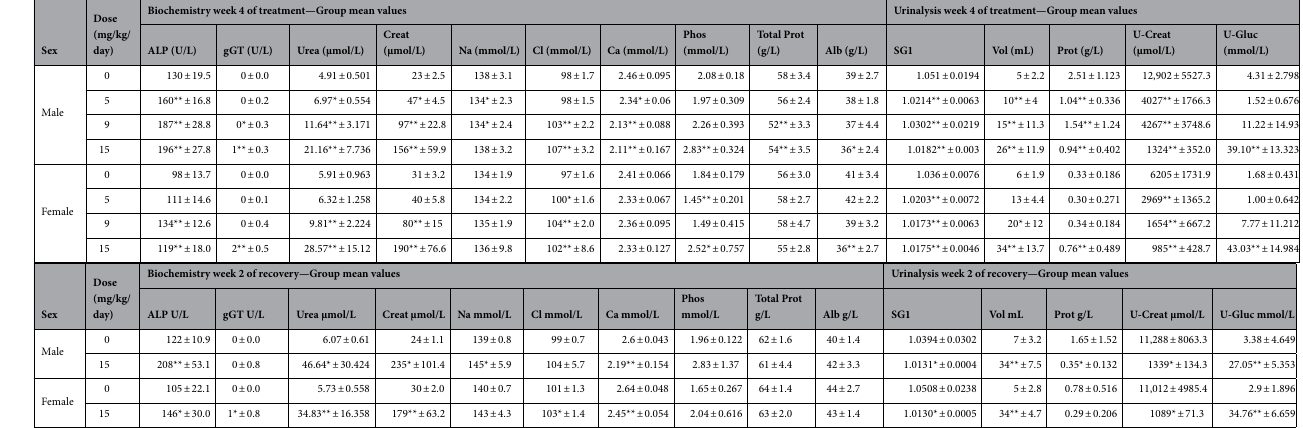
(WBC), mainly due to an increase in lymphocyte and large unstained cell (LUC) count was recorded at 15 mg/ kg/day, in both sexes. Platelet count was significantly higher than in the control group at all doses in males and females. Differences were dose-related. A slight increase in prothrombin time (SPT) and a decrease in activated partial thromboplastin time (SAPT) were recorded in both sexes at 9 and 15 mg/kg/day (Table 2). The effects on red blood cell parameters were not reversible after 2 weeks of recovery, whereas the effect on lymphocyte count seemed to be reversible, as no significant differences compared to control were recorded in males or females (Table 2). A significant dose-related increase in alkaline phosphatase was recorded at all dose levels in animals treated at 9 and 15 mg/kg/day. Increased gamma-glutamyl-transferase (gGT) was also observed in females at 9 and 15 mg/kg/day. A sharp dose-related effect on urea and creatinine was recorded at all doses, being statistically significant in all cases except in females at 9 mg/kg/day. Urea levels were more than 4 times control group values at 15 mg/kg/day. Creatinine values were more than 6 times control group values at 15 mg/kg/day. A significant decrease in albumin levels (and in total protein levels in males) was observed at 15 mg/kg/day (Table 3). Differ- ences in alkaline phosphatase, gGT (mainly in females), bilirubin, urea and creatinine values had not reversed after 2 weeks of recovery. A higher dose-related volume of urine than in the control group was observed at all doses. The specific grav- ity recorded in all SET-M33-treated groups was lower than in controls. Differences were statistically significant except for volume in females at 5 mg/kg/day. Creatinine levels lower than in controls were recorded at all doses. Differences were dose-related in females. The protein levels recorded in males from all SET-M33-treated groups were significantly lower than in controls. Statistically significant differences in glucose increase were found in animals treated at 15 mg/kg/day. Differences observed at the end of treatment persisted at the end of the recovery period. Group mean values of significant changes are reported in Table 2 and Table 3. Necroscopy. Necroscopy and histopathological examinations were performed at the end of treatment and at the end of the recovery period. Macroscopic changes were recorded in the kidneys (pale coloration and a reddened medullary area in almost all males and females from groups on 9 and 15 mg/kg/day) and bladder (distended in a few males of all treated groups). These findings were also recorded at the end of the recovery period affect- ing all animals dose at 15 mg/kg/day (pale coloration of the kidneys) or one male (distended urinary bladder). The mean weight of the kidneys, liver and spleen was significantly higher with respect to control group in both sexes at all dose levels. At the end of the recovery period the mean weight of the spleen (both sexes) and the mean weight of the kidneys and ovaries (females) from animals treated at 15 mg/kg/day were still higher with respect to control group. The microscopic examination revealed SET-M33-related findings in kidneys (all dose levels), femorotibial growth plate, brain, duodenum and ovaries (doses of 15 and 9 mg/kg), and in bone marrow, heart, uterine cervix and vagina and mammary glands (dose of 15 mg/kg). For 15 mg/kg/day group, the changes observed in the kidneys, bone marrow, uterine cervix and vagina were not reversible (see Supplementary Mate- rial for images and number of animals affected by these irreversible abnormalities), while the rest of the find- ings were fully (femorotibial growth plate and duodenum) or partially recovered (heart, ovaries and mammary glands) after 2 weeks of recovery period.